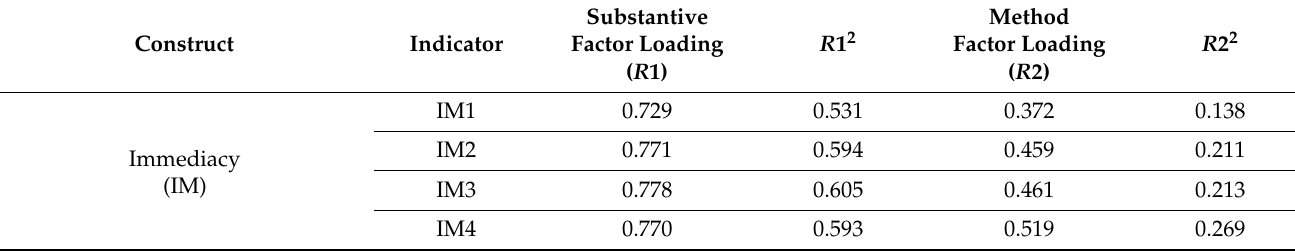
Table A2. Common method bias